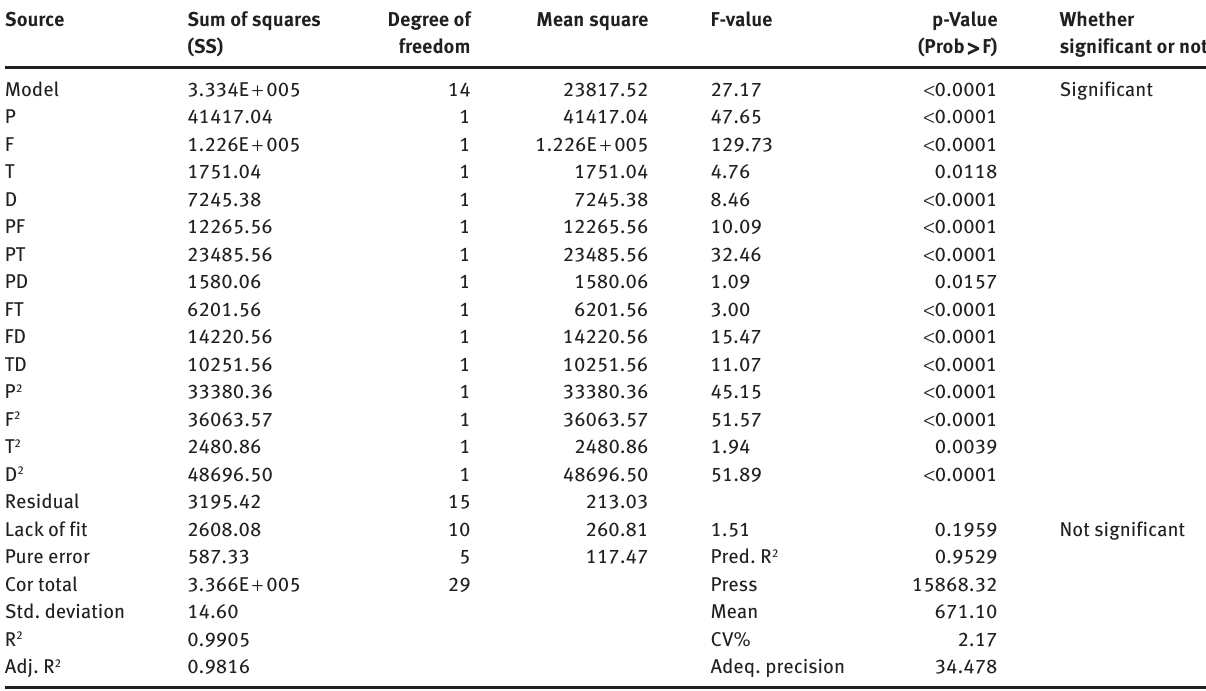
Table 7: ANOVA test results. Source